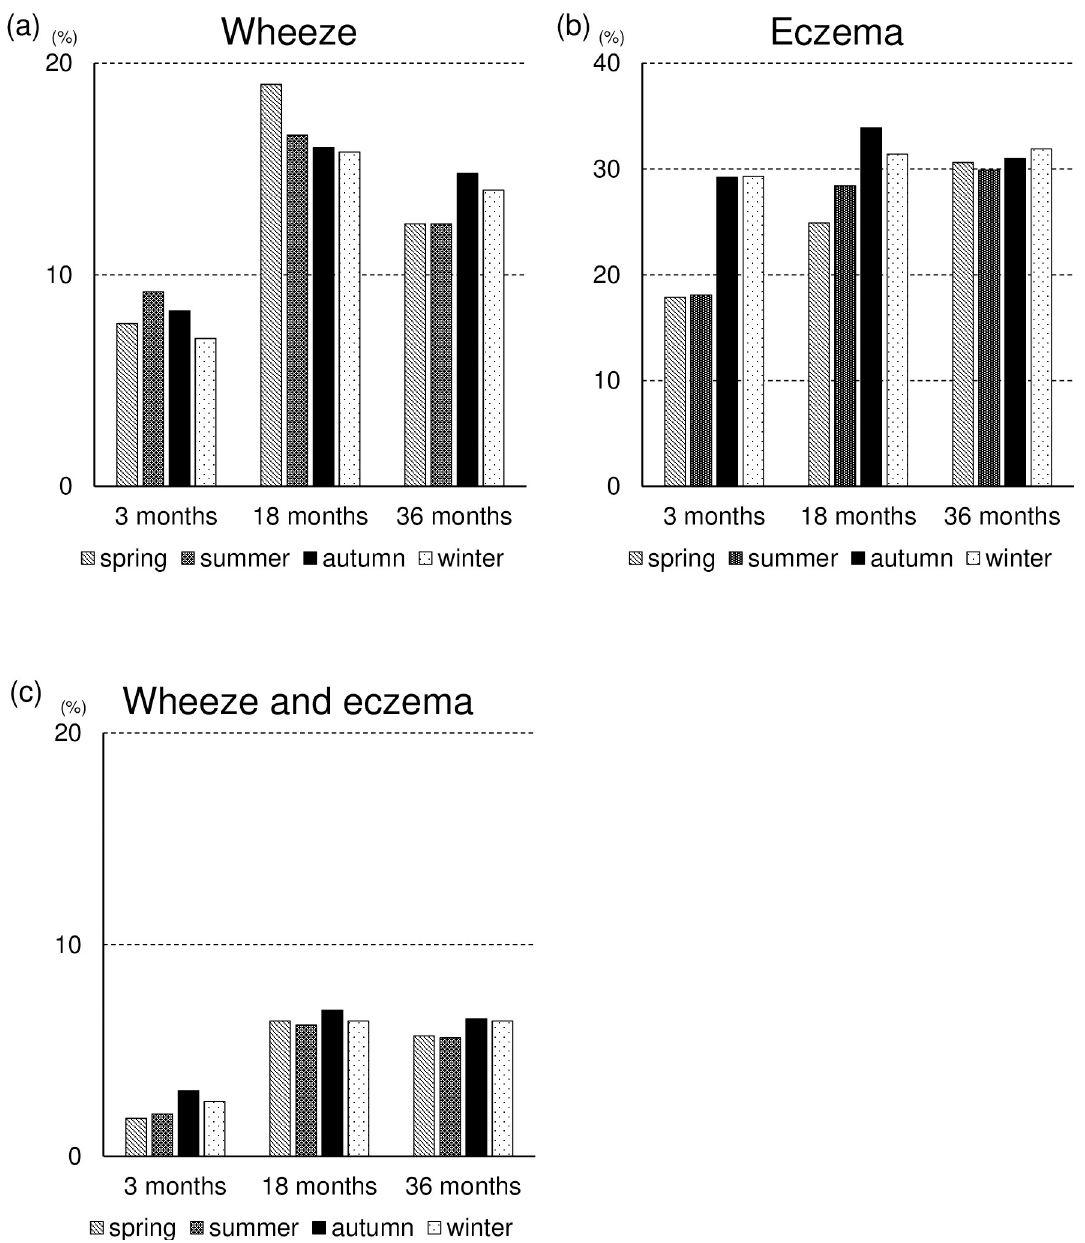
Fig 2. Prevalence of (a) wheezing, (b) eczema and (c) both wheezing and eczema in each season. Spring (months of March, April, and May), summer (months of June, July, and August, autumn (months of September, October, and November), and winter (months